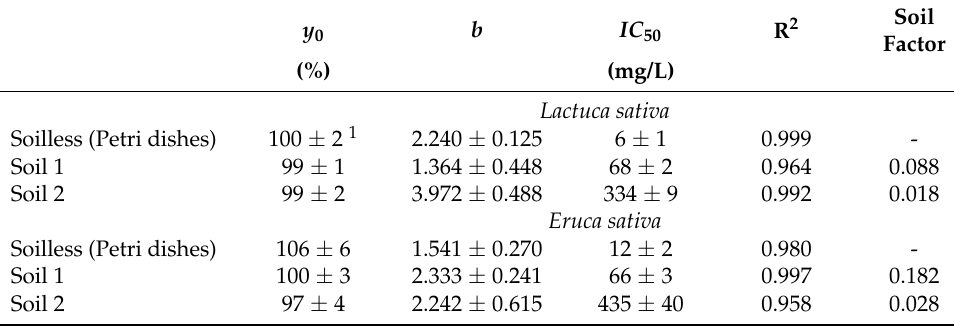
Figure 4. Dose-response curves for the inhibitory effect of umbelliferone on the root growth of L. sativa , E. sativa , and H. vulgare under Petri dish conditions and in the presence of two soils (t = 6 days). Table 2. Log-logistic 3-parameter constants for the effect of umbelliferone on the root length of L. sativa , E. sativa , and H. vulgare in bioassays conducted in the absence and the presence of